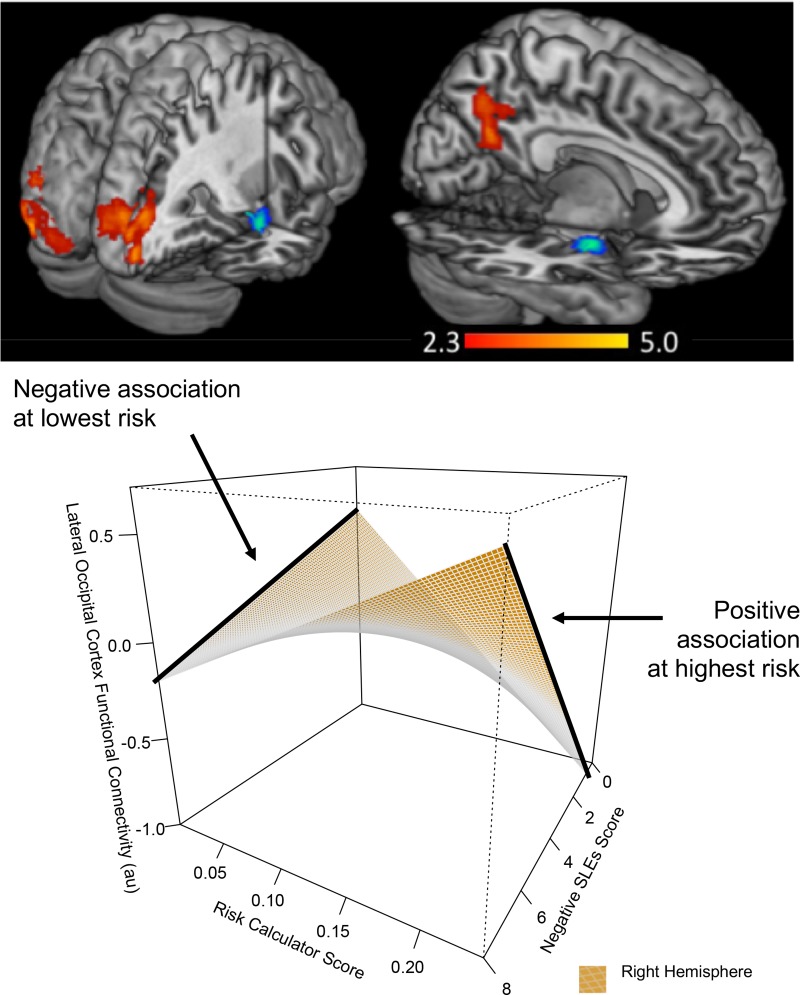
Interaction effects of risk calculator score and negative stressful life events schedule (nSLES) score on whole-brain functional connectivity to bilateral amygdala during emotion processing (top).Positive interactions between risk calculator score, nSLES score and activity were found within 2 clusters after correction for multiple comparisons. A graphical representation of this interaction in the right lateral occipital cortex is presented here (bottom). Higher risk calculator score showed a greater positive association between functional connectivity and nSLES score, which was not present at low risk calculator score. A full set of these interaction plots can be found in the supplementary. * au = arbitrary units All results were corrected for using Z-statistic threshold at z>2.3, pFWE<0.0017. A contrast of all emotions versus shape conditions was used. Functional connectivity values were mean adjusted using a healthy control sample.